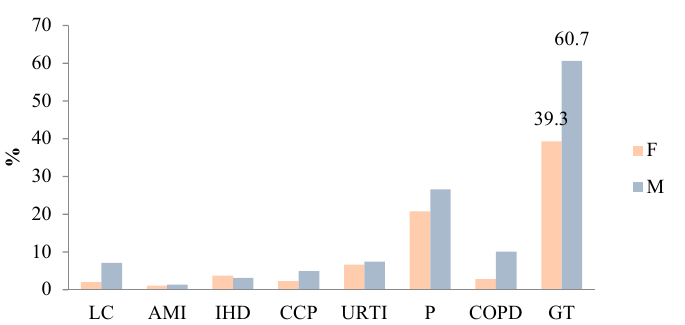
Figure 8. Disease frequency in different age categories and gender distribution.